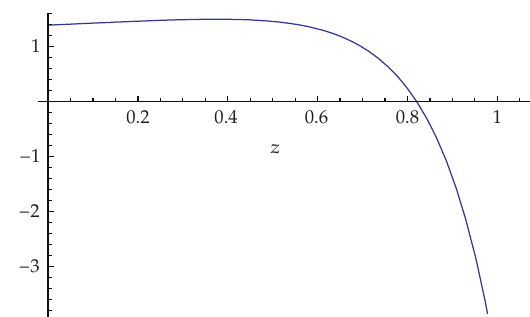
Figure 1: The plot of Γ against z for Ω m 0 (cid:2) 0 . 18 shows that Γ > 1 for z < 0 . 7, and is nearly constant for z < 0 . 55. Thus, the field starts tracking for z ≤ 0 .